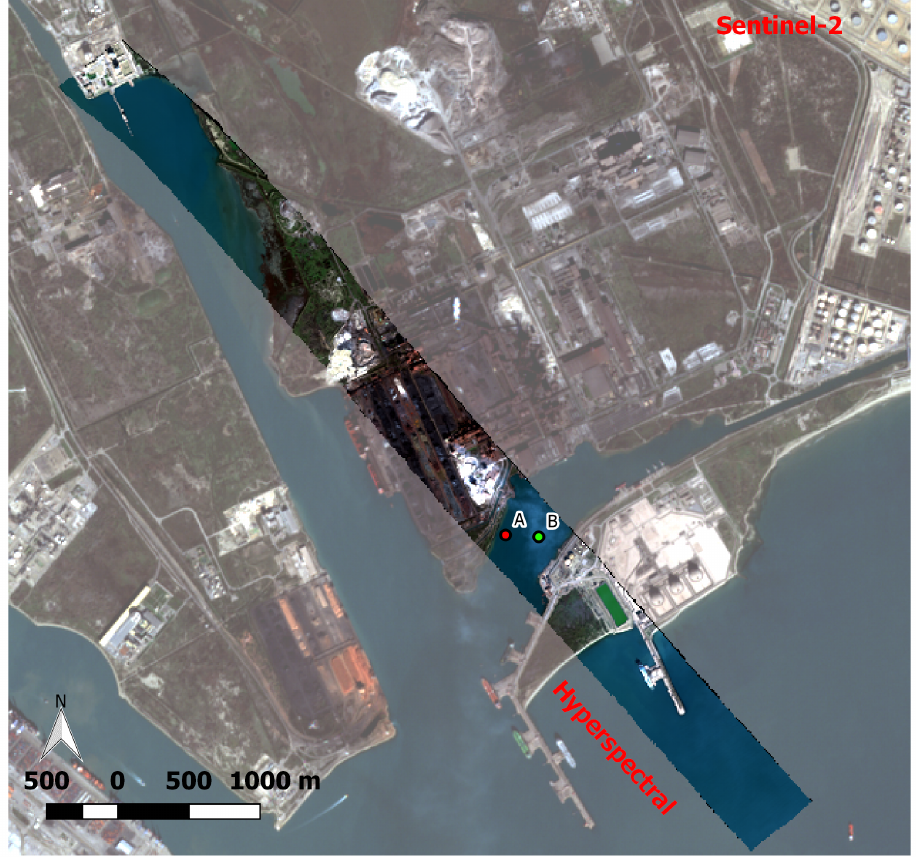
Figure 3. HYSPEX hyperspectral image (opaque) superposed on the Sentinel-2 image (transparent). Points A and B, respectively, represent areas of interest for the spectra used in Figure